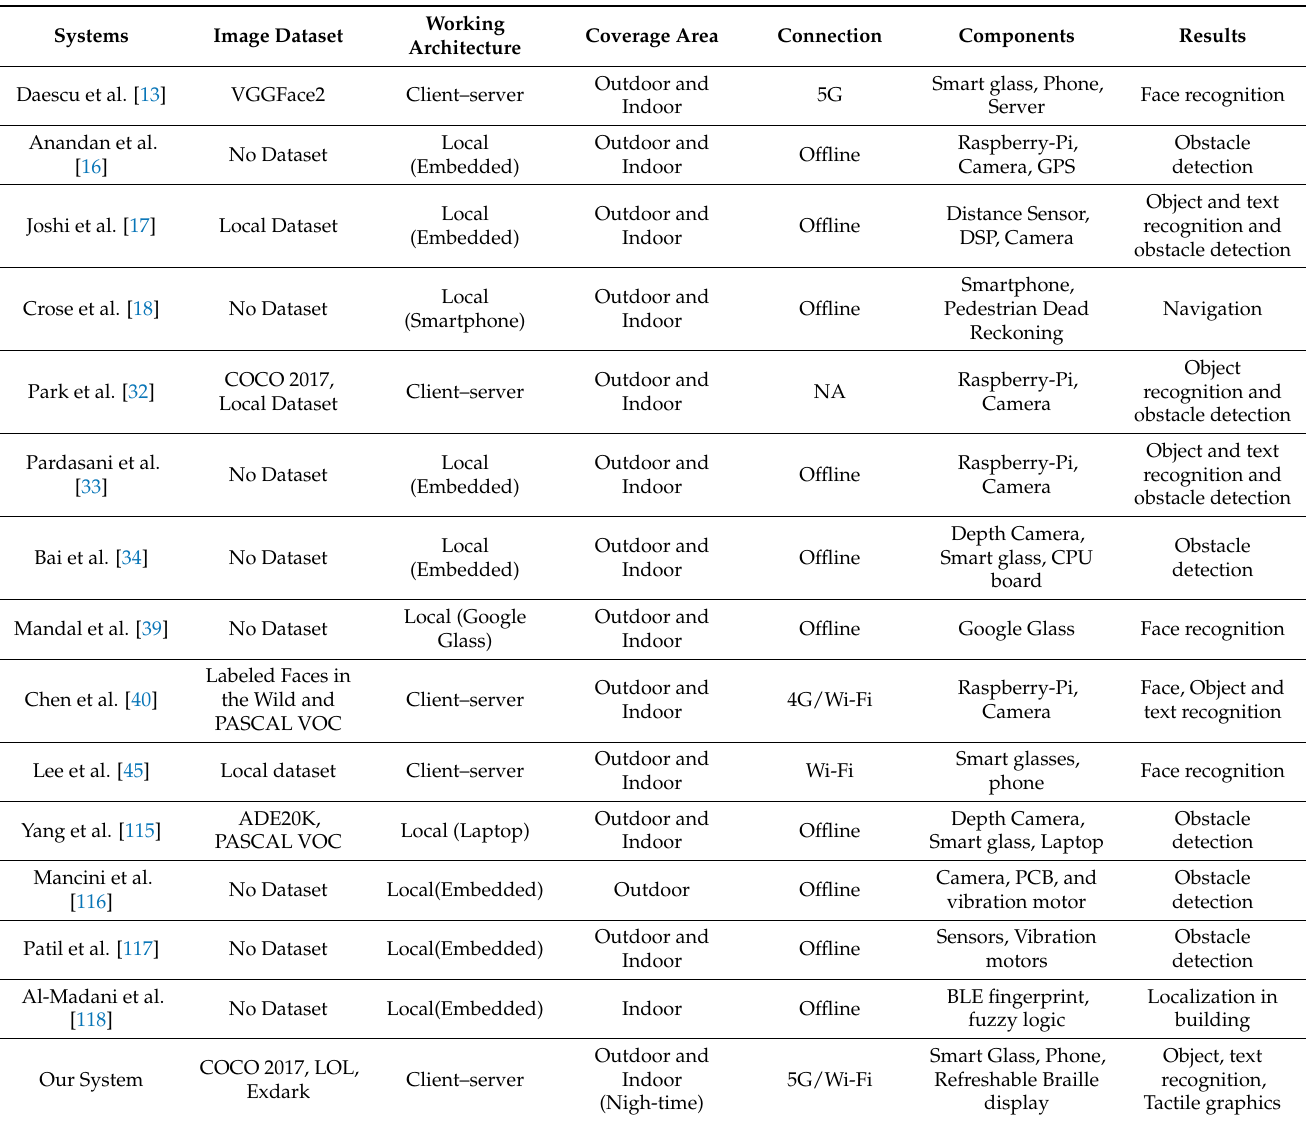
Table 9. The comparison with cutting edge